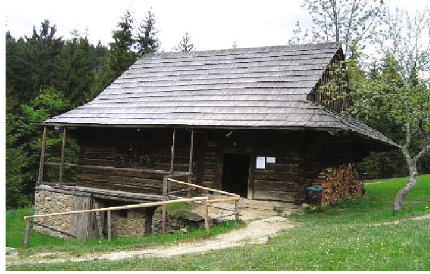
Figure 59: A log cabin in Slovakia [36].